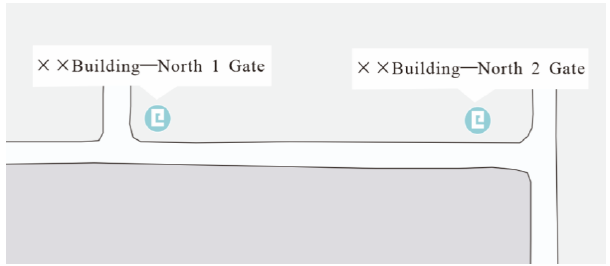
ff erent POIs with a high name Figure 1. Different POIs with a high name similarity. Figure 1. Di